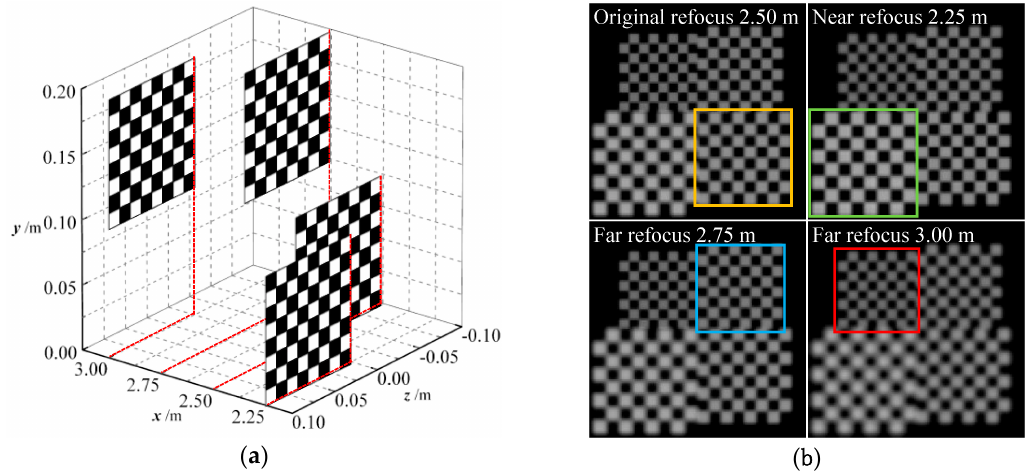
Figure 8. Imaging and correction target for the real scene light field. ( a ) Staggered checkerboards placed at x = 2.25, 2.50, 2.75 and 3.00 m; ( b ) Ideal refocused images at the respective depths.